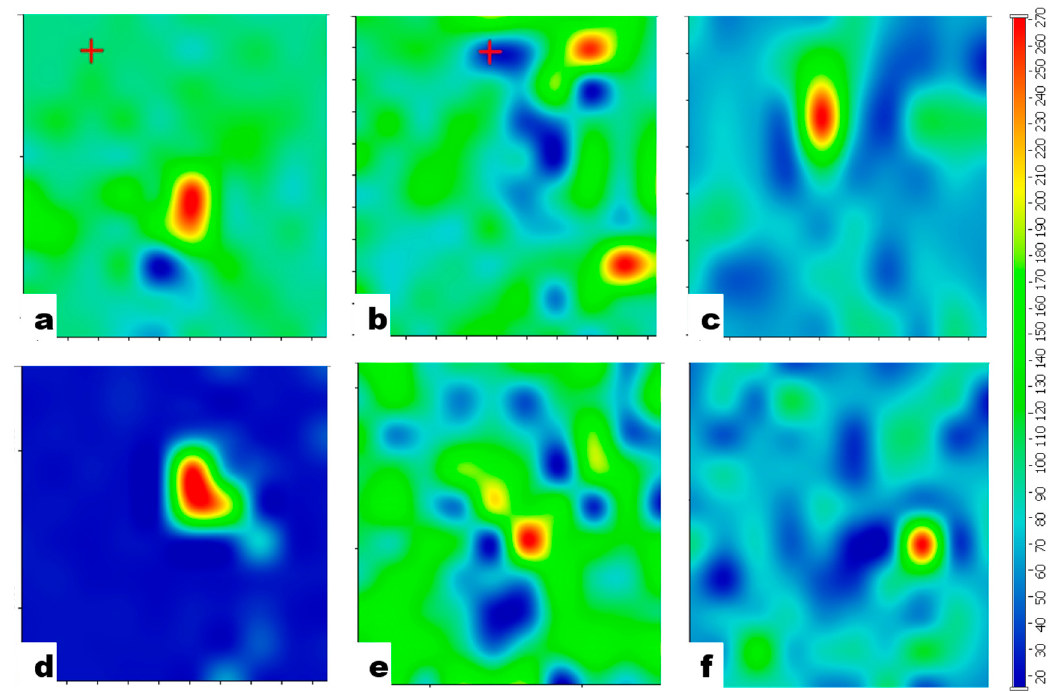
Figure 6. Raman mapping of the surface of nanomodified elastomers: ( a )—3%; ( b )—4%; ( c )—5%; ( d )—6%; ( e )—7%; ( f )—8%.